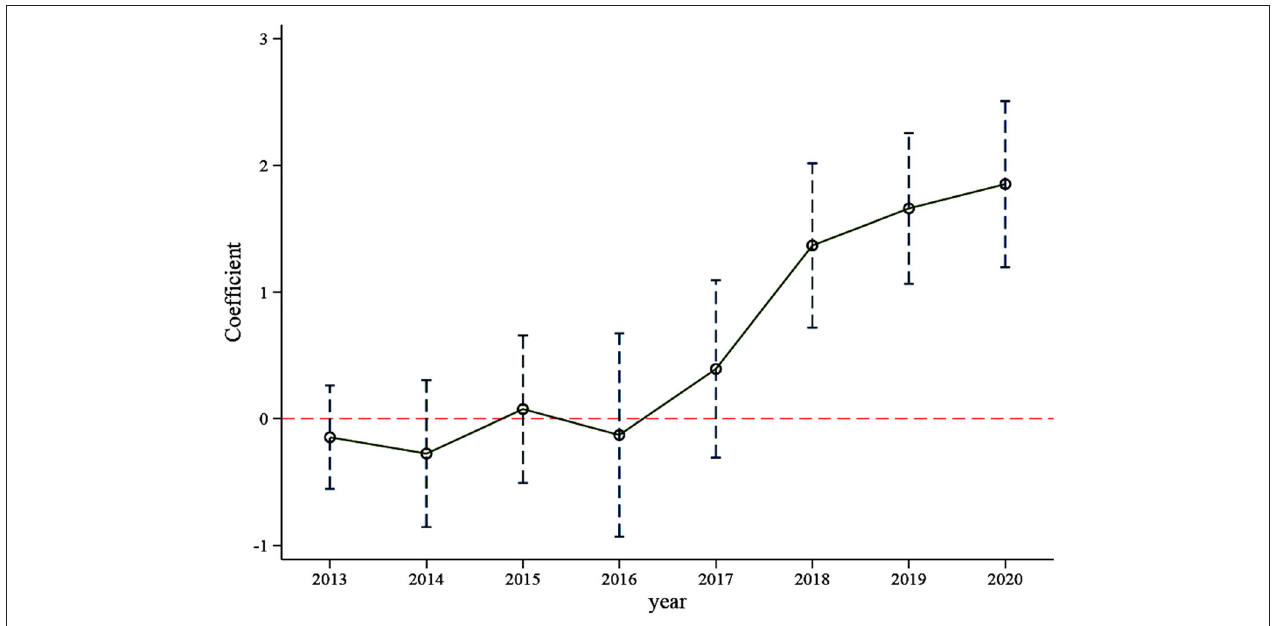
FIGURE 2 | Parallel trend test (with control variables).